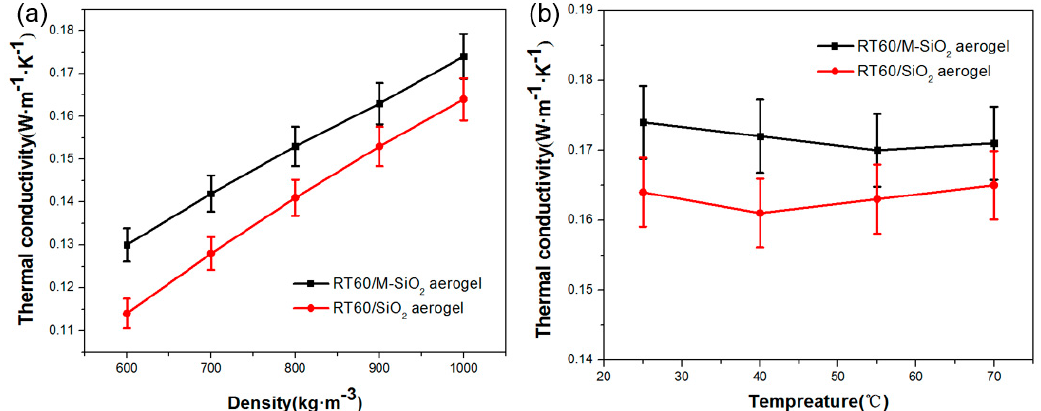
Figure 9. Thermal conductivity of RT60/SiO 2 and RT60/M-SiO 2 aerogels with different packing densities ( a ) and different temperatures ( b ).